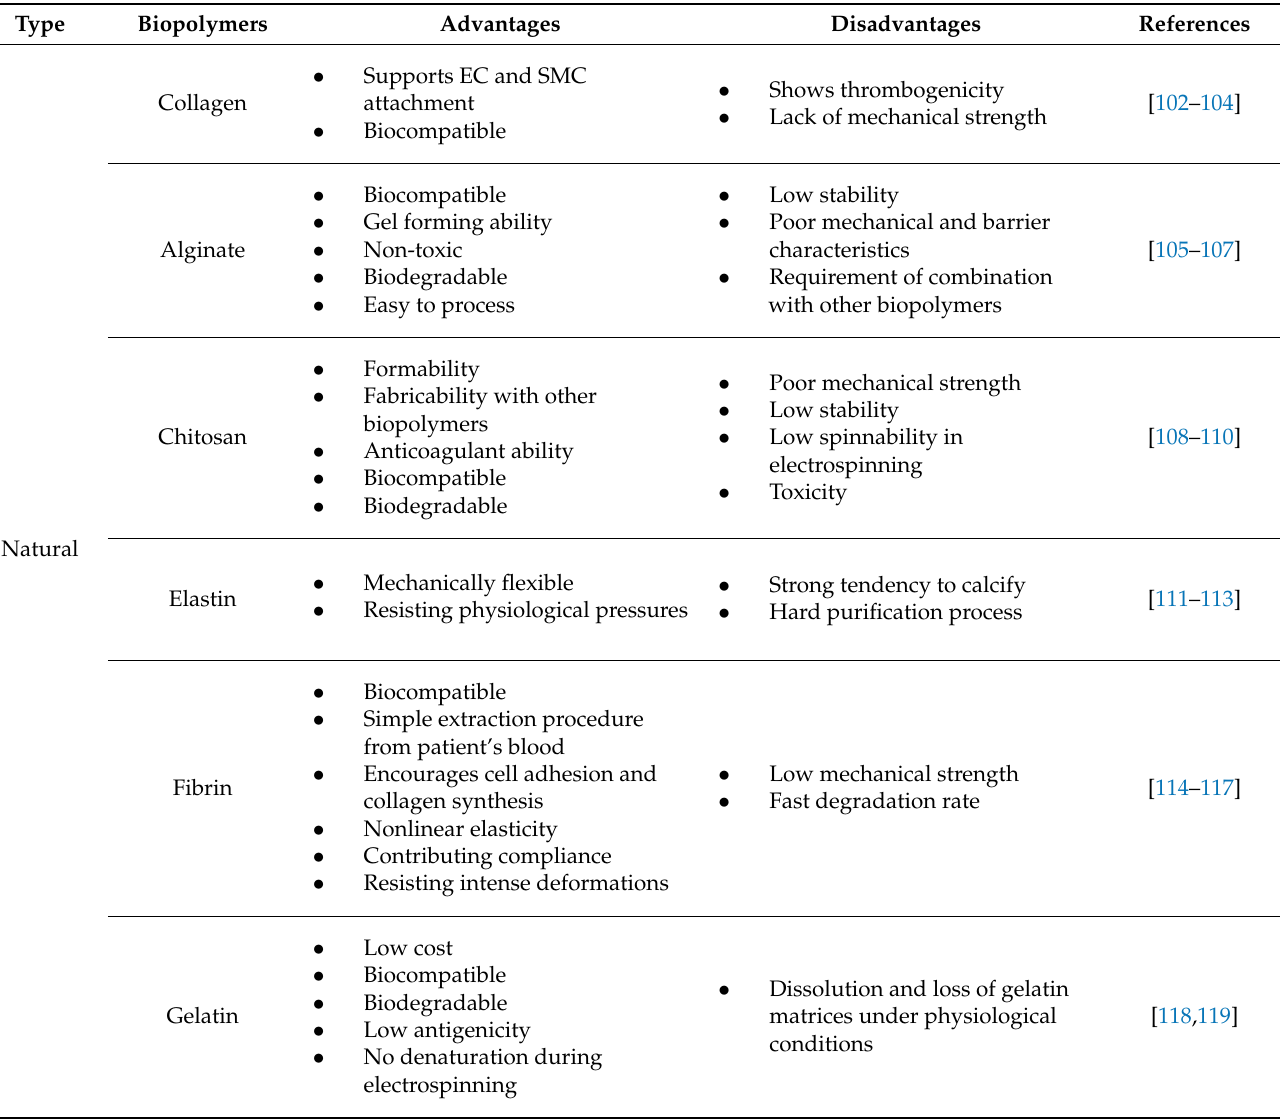
Table 1. Some of the advantages and disadvantages of natural and synthetic biopolymers used in tissue